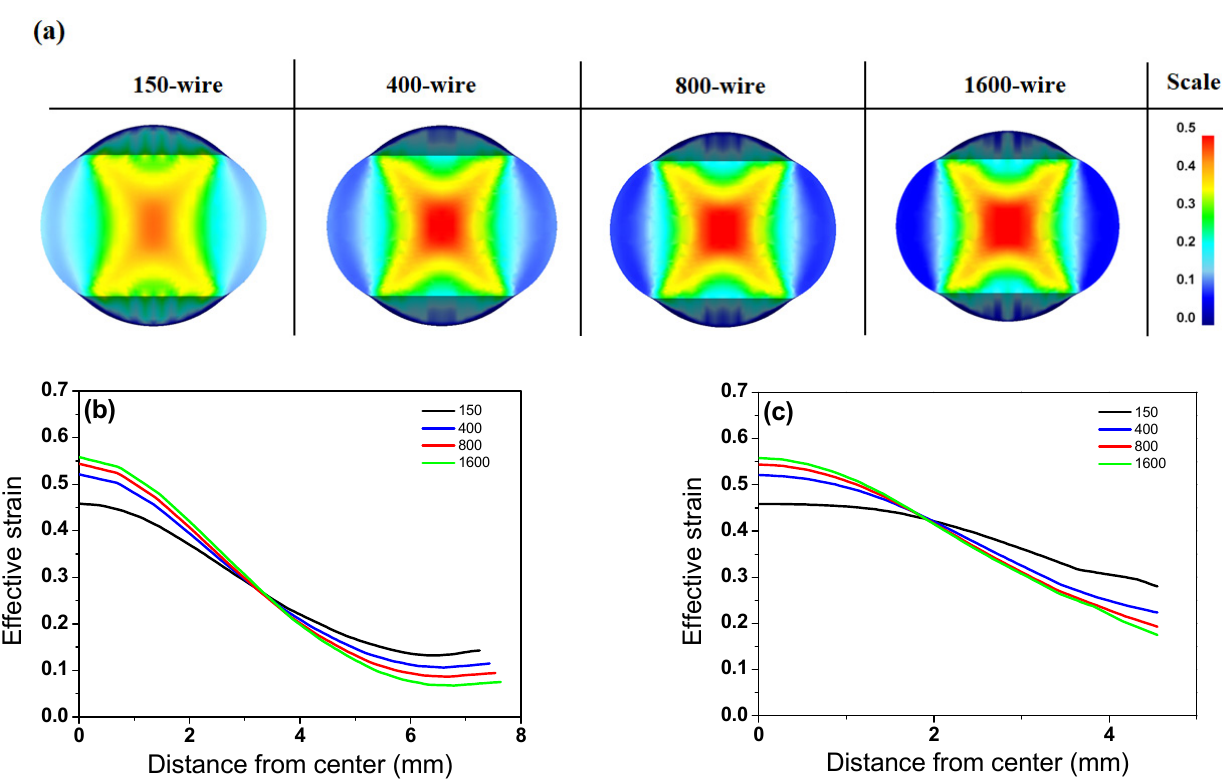
Figure 5. Comparison of effective strain ( a ) contours and profiles along the ( b ) horizontal and ( c ) vertical directions with the roll diameter.